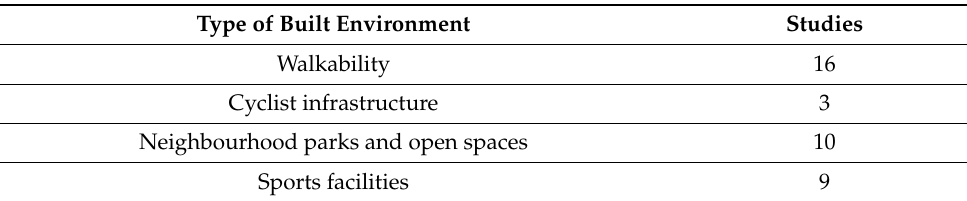
Table 3. The number of studies that have examined motives and barriers within each of the four types of built